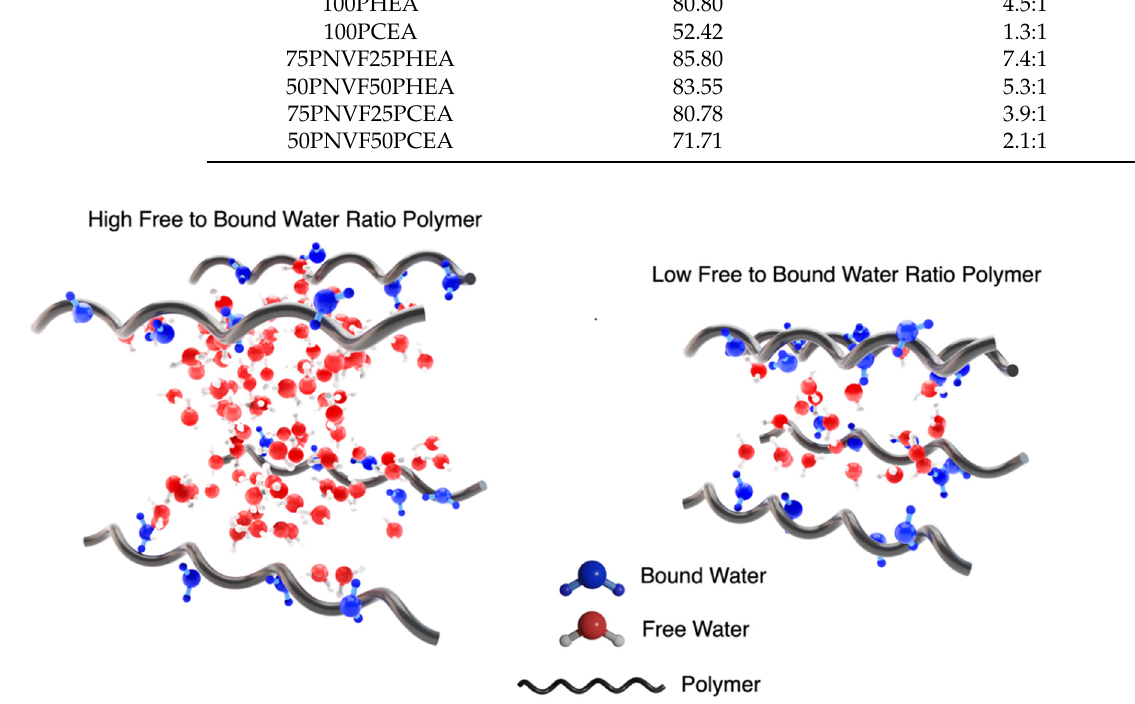
Figure 3. Schematic representation of the free to bound water in a high ratio and low ratio system.